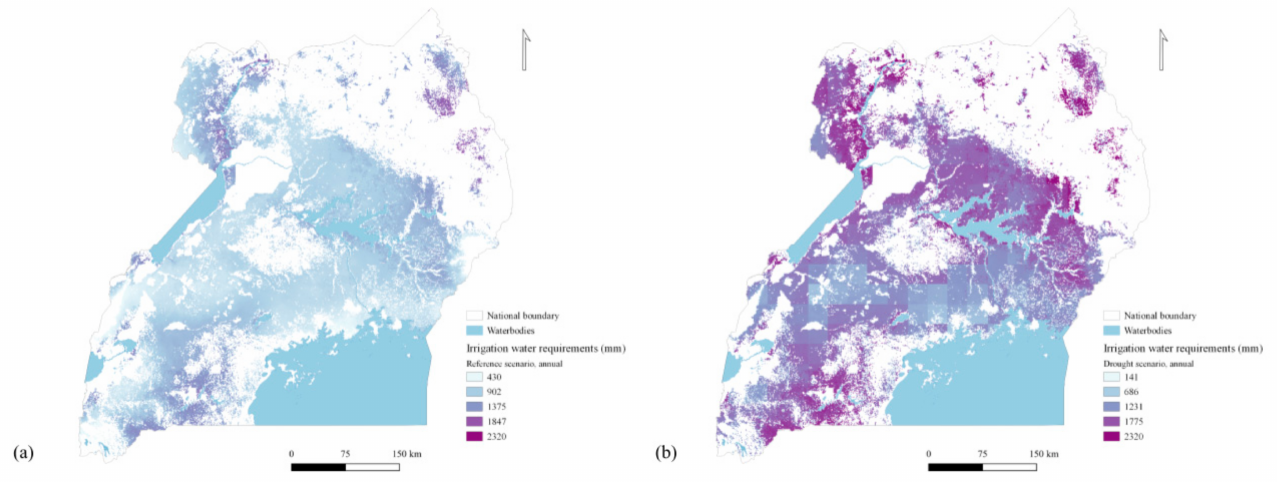
Figure 10. Estimated annual irrigation water requirements (mm) in the reference and drought scenario, respectively. The results are presented as follows: ( a ) annual irrigation water requirements in the reference scenario and ( b ) annual irrigation water requirements in the drought